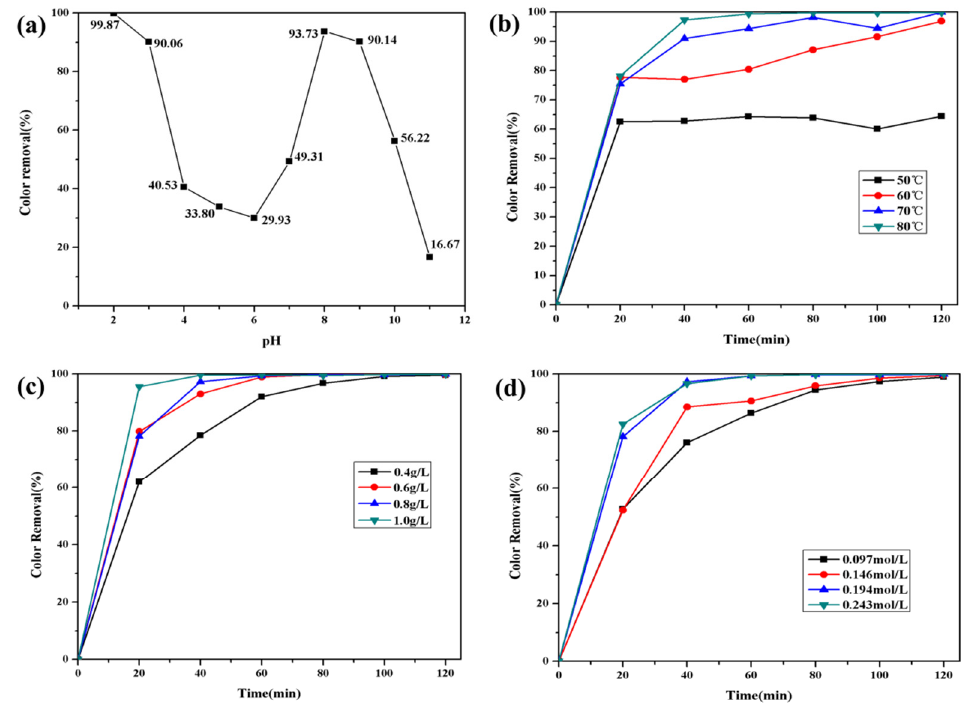
Figure 9. Decolorization effect of MO ( a ) with pH: ([MO] 0 = 100 mg/L, [Fe 2 O 3 /CNFs] 0 = 0.6 g/L, [H 2 O 2 ] 0 = 0.155 mol/L, T = 80 °C, t = 2 h); ( b ) with temperature: ([MO] 0 = 100 mg/L, [Fe 2 O 3 /CNFs] 0 = 0.8 g/L,